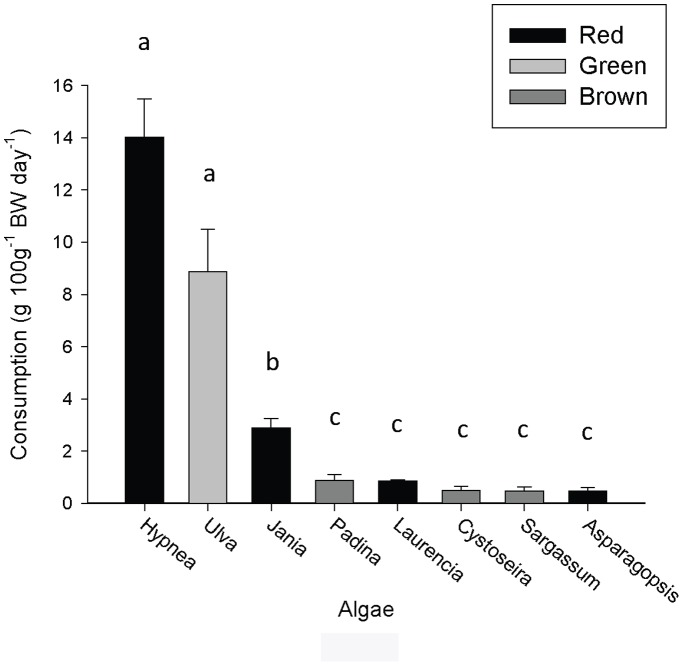
No-choice feeding assay for the 8 species of algae used in the previous choice assays.Data show mean (+SE) consumption rates (g FW algae day−1, n = 5) of algae per treatment standardised for abalone size (100g−1 BW). Abalone size ranged from 30–186 g (mean = 94.73 g). Common letters above columns indicate no significant difference (Tukey’s HSD, p>0.05).